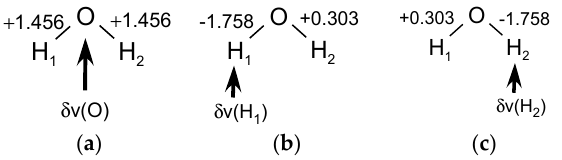
Figure 1. The linear response function of bond-order (LRF-BO) values of a water molecule for perturbations that are applied to the various sites: ( a ) the oxygen atom; ( b ) the left hydrogen atom; and ( c ) the right hydrogen atom.